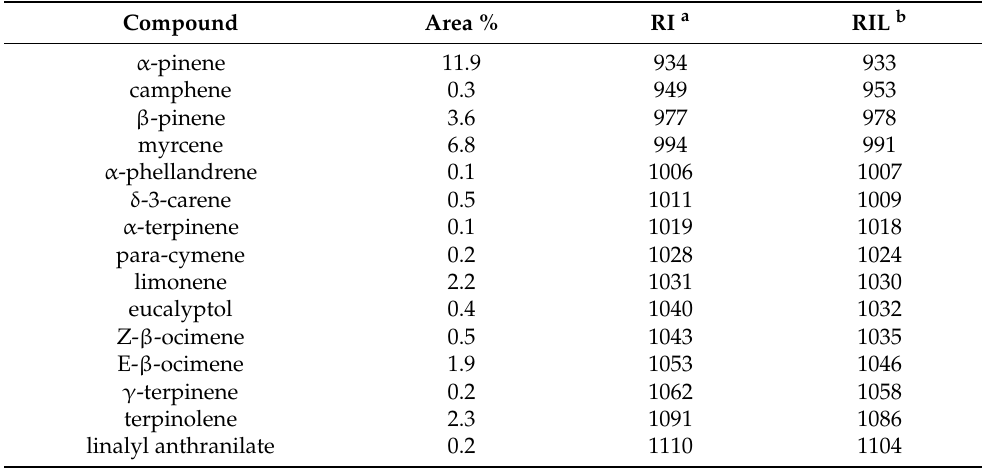
Table 1. Gas chromatography coupled to mass spectrometry detector (GC–MS) analysis of Eletta campana EO